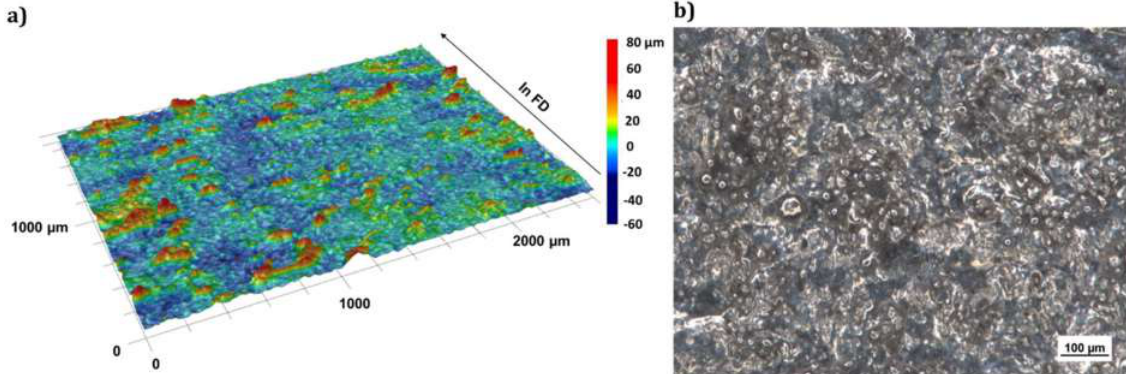
Figure 6. ( a ) 3D topography of the initial surface structures with 12-fold magnification, ( b ) 100-fold microscopic image of the initial surface.